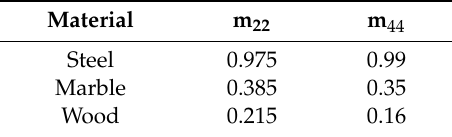
Table 1. Mueller matrix elements.